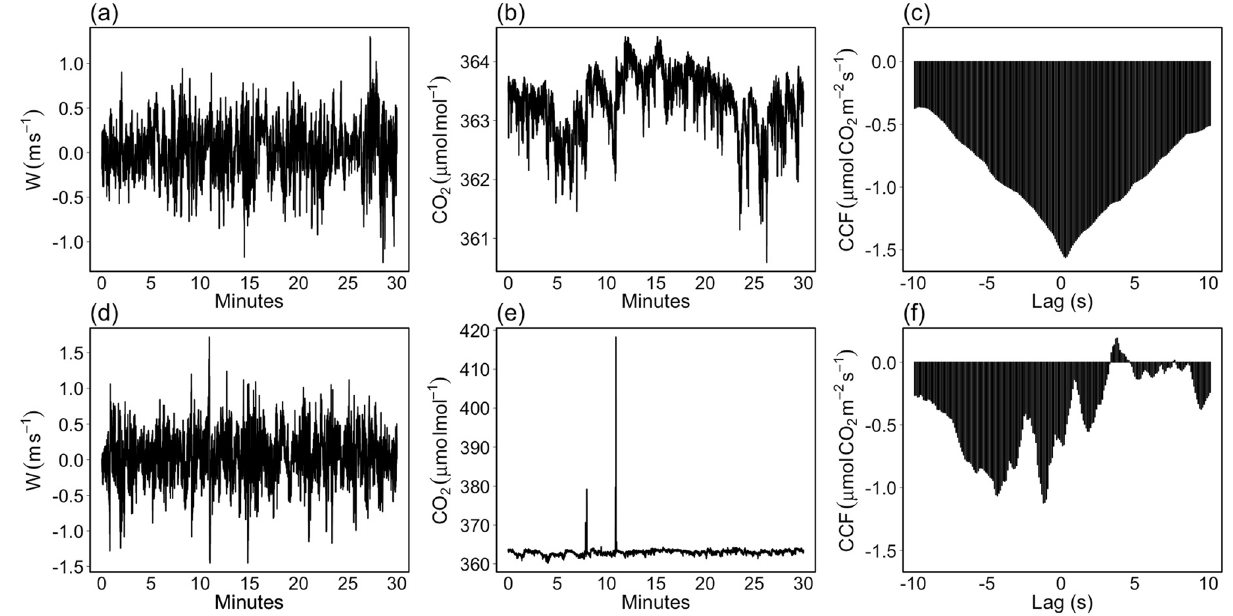
1 , a, d ), carbon dioxide concentration (CO 2 ,